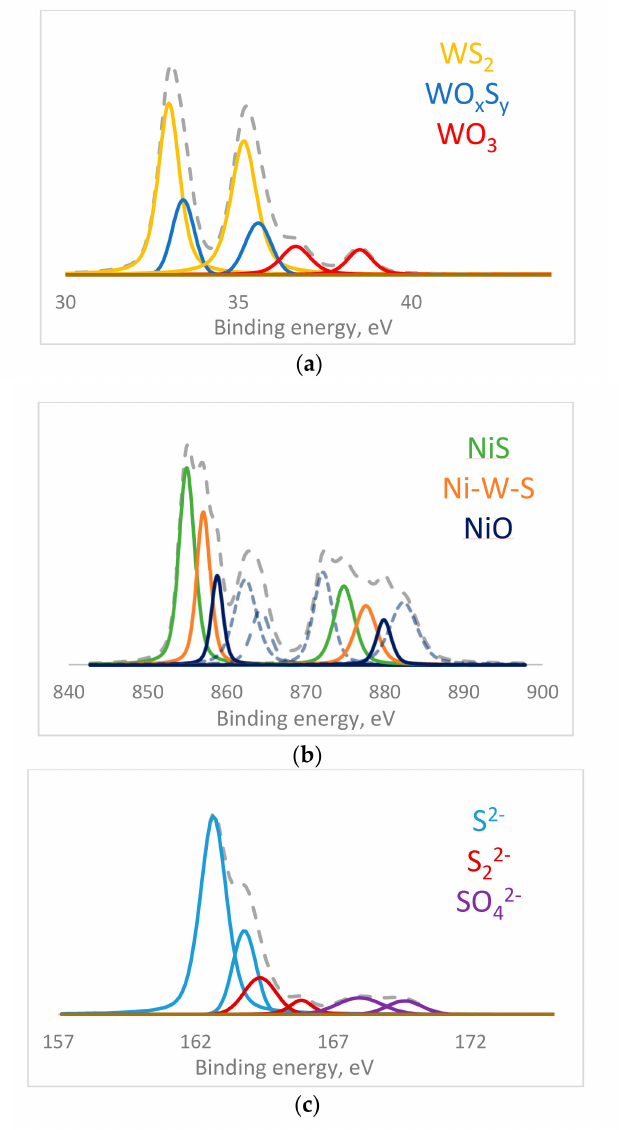
Figure 4. The ( a ) W 4f, ( b ) Ni 2p, and ( c ) S 2p XPS spectra of the NiWS-HY(0.5%)